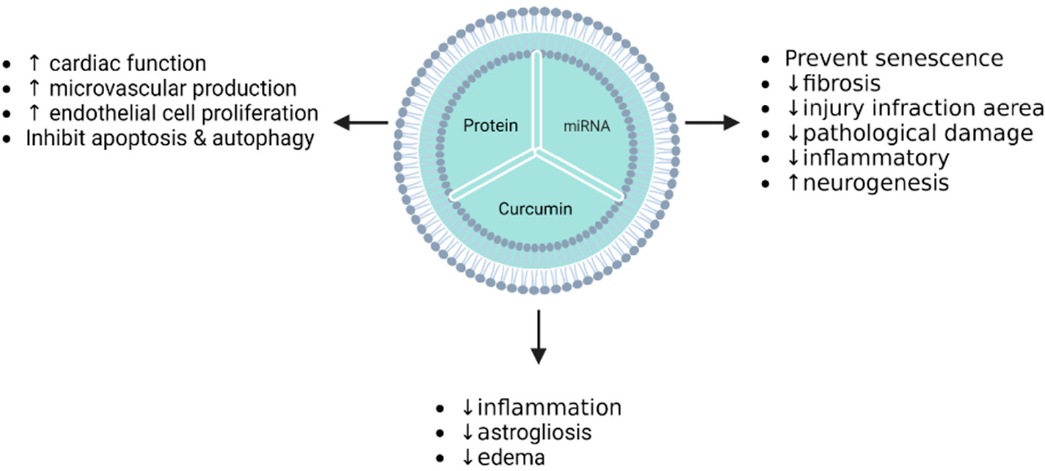
Figure 7. EV cargos and their in vivo effects on non-cancerous cells ( ↑ : increase, ↓ : decrease).